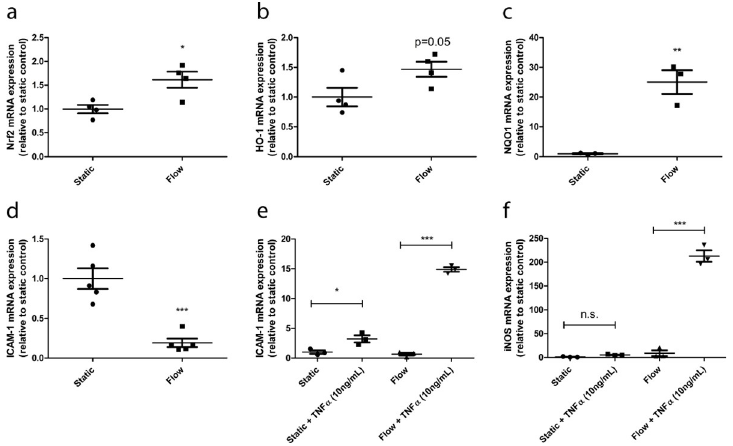
Fig 4. Laminar flow increases the expression of anti-oxidant genes and decreases the inflammatory basal state of GEnC. mGEnC were cultured under static conditions or under a laminar flow of 5 dyn/cm2 for 7 days. mRNA expression levels of Nrf2 ( A ) HO-1 ( B ), NQO1 ( C ) and ICAM-1 ( D ) in mGEnCs cultured under either static conditions or flow. mRNA expression levels of ICAM-1 ( E ) and iNOS ( F ) in mGEnCs cultured under static conditions and under flow, either unstimulated or stimulated with 10ng/mL TNF α for 18hrs � p < 0.05, �� p < 0.01, ��� p <